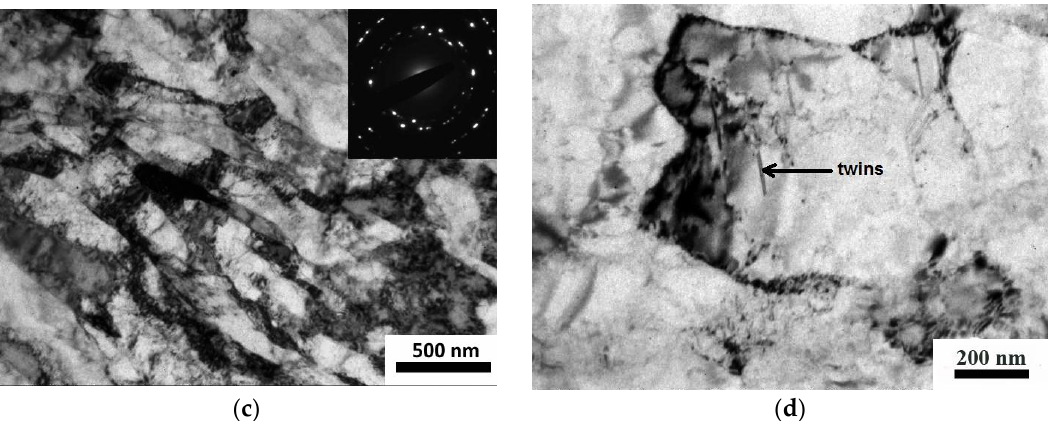
Figure 3. Microstructure of the steel after SPD processing (via ECAP) in the longitudinal section (“ECAP” condition): ( a , b ) SEM; ( c , d ) TEM, the aperture size for diffraction patterns ~1 μm 2 . Thus, after SPD processing via ECAP, a heterogeneous austenitic UFG structure is formed. This structure consisted of grains/subgrains elongated in the direction of straining, with a small number of twins.